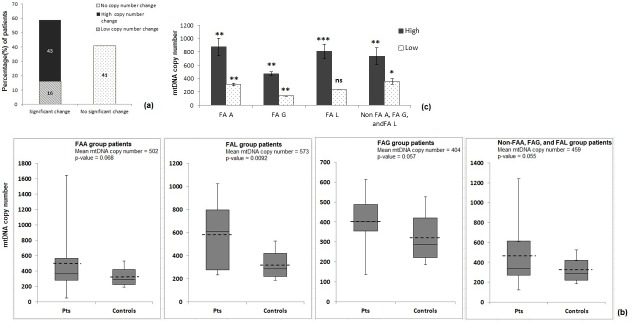
mtDNA copy number change study.(a) Frequency distribution of mtDNA copy number change among FA patients (%), (b) Whisker and box plot for mtDNA copy number change among different FA complementation group patients. Dashed line represents mean mtDNA copy number (Pts.: Patients), and (c) mtDNA copy number change (Low and High) among patients of different FA complementation groups (ns: not significant, *: p<0.05, **: p< 0.01, and ***: p<0.00001).